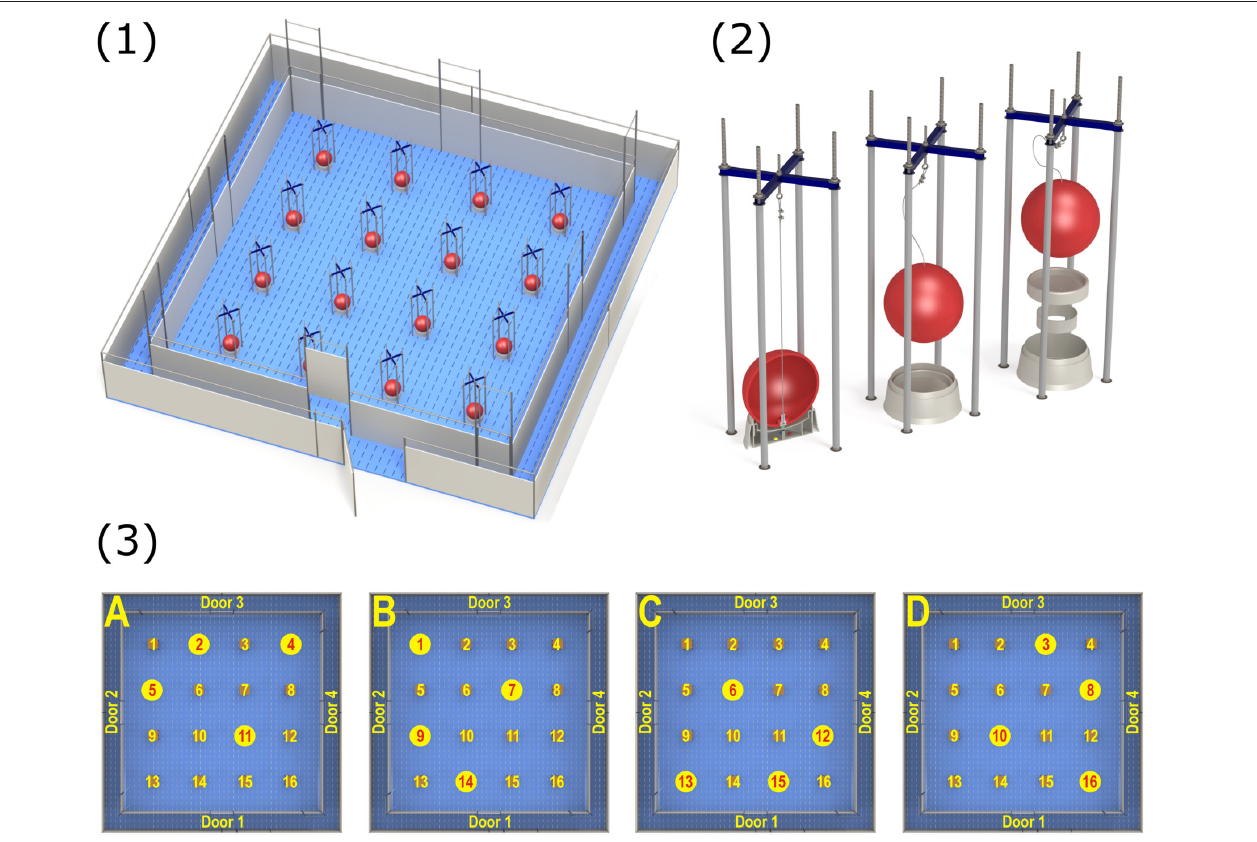
FIGURE 1 | (1) Overview of the spatial holeboard apparatus. (2) Details of the food bowls (holes). Each bowl is covered with a red ball to hide visual cues. The bowls are equipped with a false bottom covering four candies to mask odor cues. (3) The different reward configurations (A–D) used during holeboard training. Baited holes are highlighted (illustrations: Yorrit van der